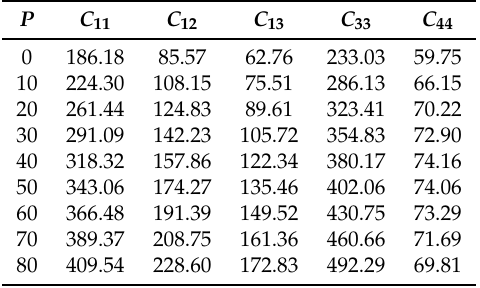
Table 2. The elastic constants C ij (in GPa) of Ti 3 Al under pressure up to 80 GPa.